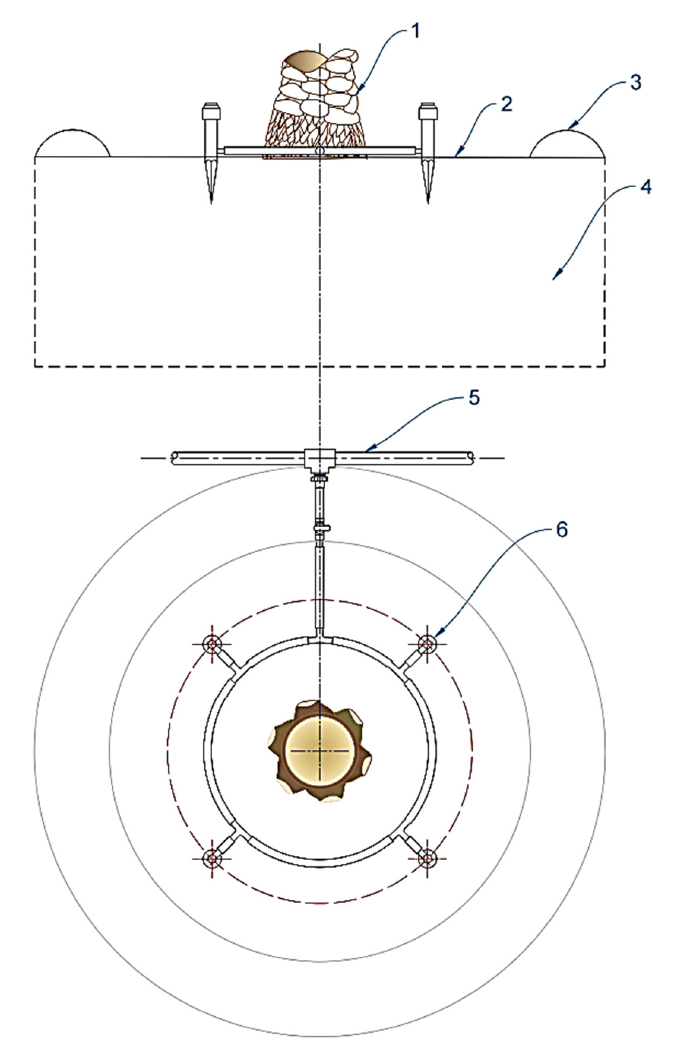
Figure 6. The main components of the bubbler distribution around date palm trees. (1) Date palm tree, (2) soil surface, (3) contour line, al ring, (4) irrigation target zone, (5) distribution line, and (6) pressure ‐ compensating bubbler.